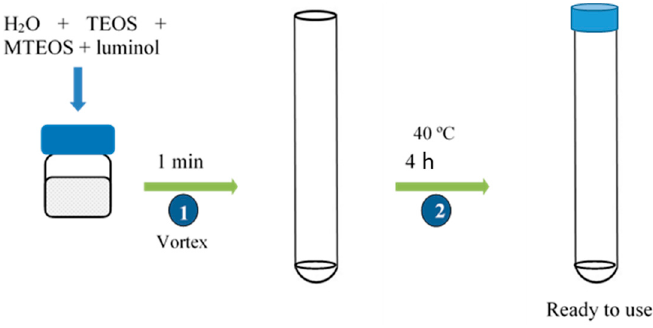
Figure 2. Procedure of TEOS/MTEOS/luminol sensor fabrication. Table 2. Different mixtures tested in order to develop a luminol sensor. For all mixtures, 4.4 µL of nanopure water was used.